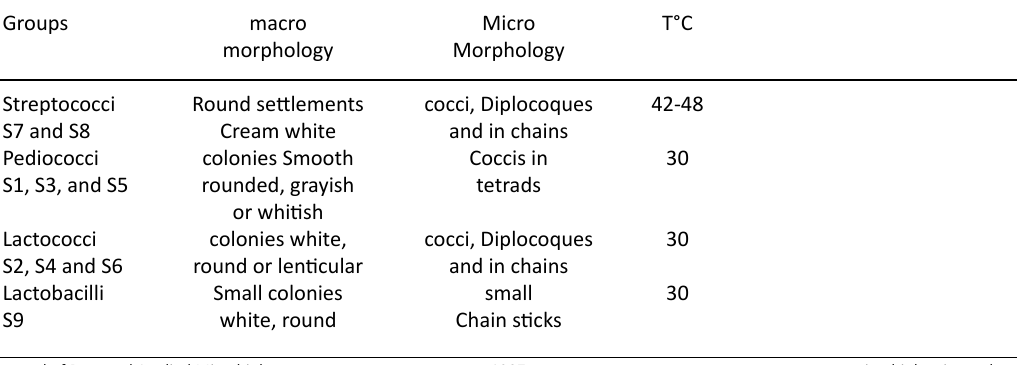
Table 2. Morphological characteristics of lactic acid bacteria isolated Groups